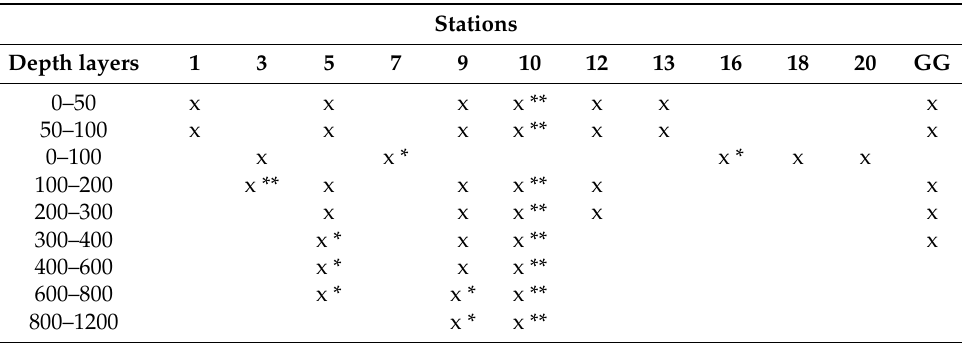
Table 1. List of samples collected in the southern Adriatic in December 2015 and April